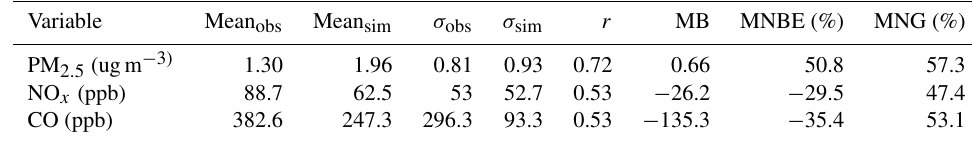
Table 7. Evaluation indexes for model performance of air pollutants during the simulation period (baseline scenario C0). Variable Mean obs Mean